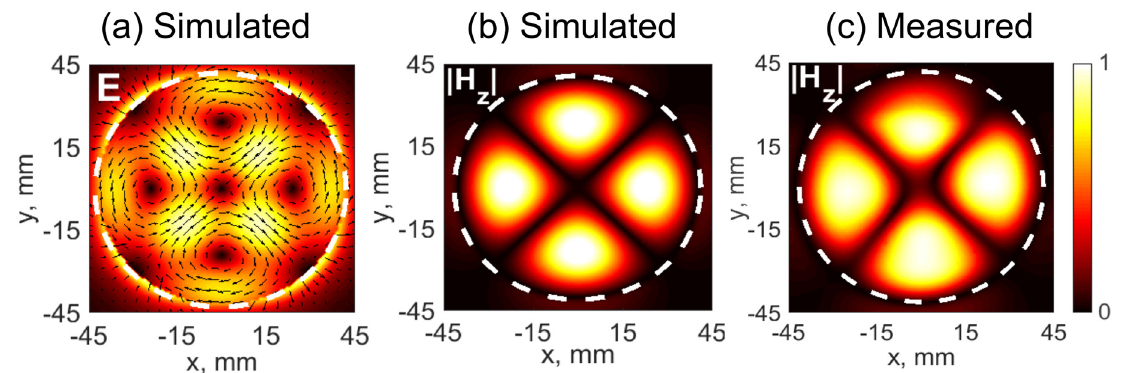
Figure 2: Near-field distributions of NR source at the frequency of 408.6 MHz. (a) Simulated electric field, (b) simulated and (c) measured normal component of the magnetic field distribution of the NR source. The fields are shown 2 mm above the dielectric disk surface. The filed magnitudes are normalized to the maximum field intensity value (Maximum of the simulated electric field is 4628 V/m and maximum of the Z component of the simulated magnetic field is 152 A/m.). The white dashed lines represent the dielectric disk radius.